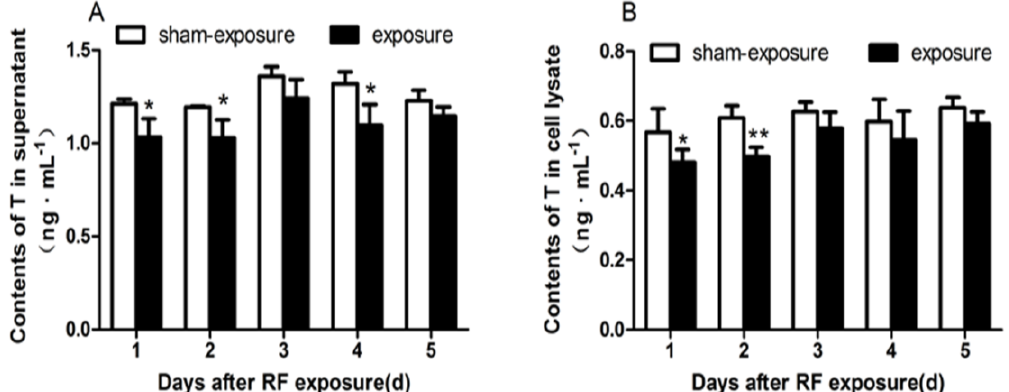
Figure 4. Testosterone contents in TM3 Leydig cells at day 1 to day 5 following exposure to RF-EMR. ( A ) Contents of T in the supernatant of TM3 cells; ( B ) Contents of T in the lysate of TM3 cells. Values represent mean ± SEM for each of the exposure and sham-exposure groups at each time point. ** p < 0.01 vs. sham-exposure (Student t -test), * p < 0.05 vs. sham-exposure (Student t -test).